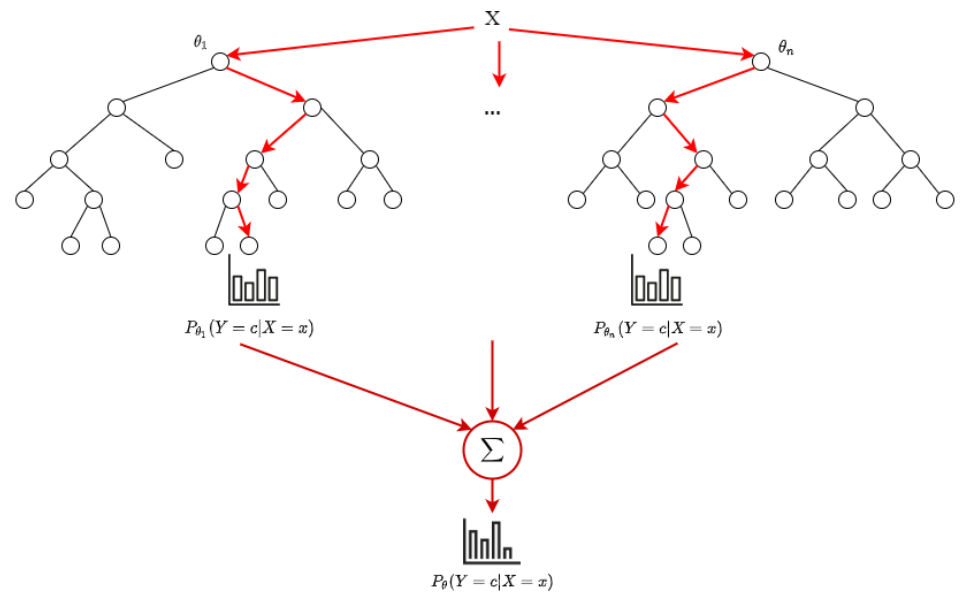
Figure 4. Classification by Random